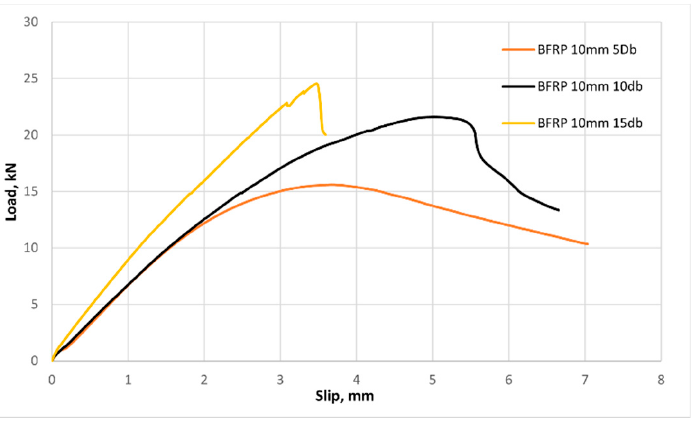
Figure 19. Load–slip relationship of specimens with 10-mm BFRP bars of 5 d b ,10 d b , and 15 d b embedment lengths.